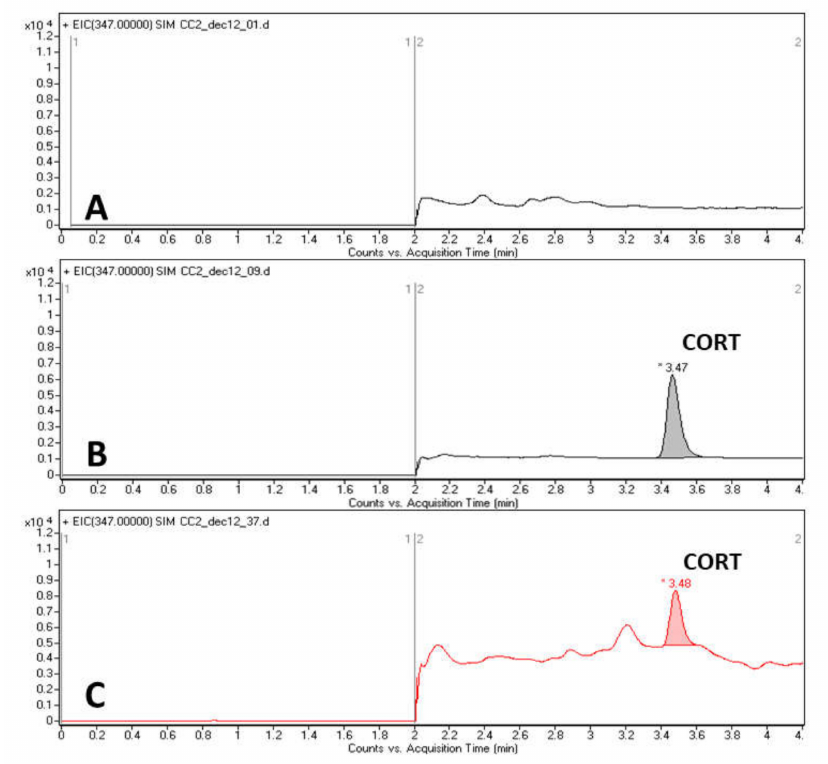
Figure 2. Representative HPLC chromatograms obtained: A . blank solution (20 µ L 0.1% formic acid (v / v) in deionized water in 150 µ L methanol); B . standard solution (15 ng / mL), C . real sample (10.48 ng / mL).